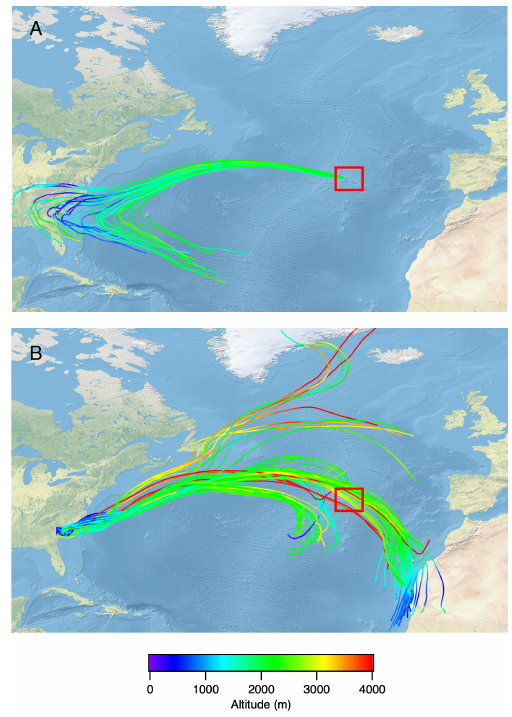
Figure 14. HYSPLIT trajectory analysis for the case study of RF no. 19 (19 July 2017). (a) A 27-member ensemble of 14d back trajectories was started from the first vertical profile loca- tion (39.172 ◦ N, 28.379 ◦ W) at 2000m altitude. Each member of the trajectory ensemble is calculated by offsetting the meteorologi- cal data by a fixed grid factor (one grid meteorological grid point in the horizontal and 0 . 01 σ units in the vertical). (b) A matrix of 80 10d forward trajectories was started from an evenly spaced grid bounded by (34 ◦ N, 81.75 ◦ W), (34 ◦ N, 79.5 ◦ W), (32.6 ◦ N, 81.75 ◦ W) and (32.6 ◦ N, 79.5 ◦ W) at 500m altitude. In both cases, GDAS 0.5 ◦ meteorology and isentropic vertical motion were used. The red box indicates the location of the Azores. The map was created using public domain map data on Natural Earth (https: //www.naturalearthdata.com/, last access: 12 March 2020) and the GSHHG database (https://ngdc.noaa.gov/mgg/shorelines/, last